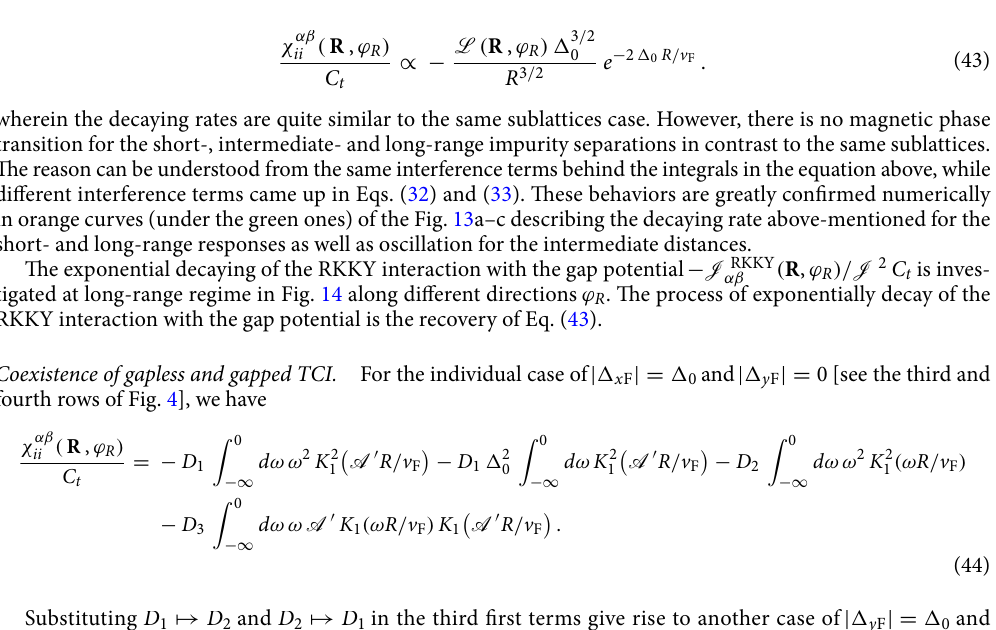
2 C 1, ϕ (� 0 R / v F J RKKY R )/ J t as a function of αβ − ≫ 200 Å for different directions ϕ R =